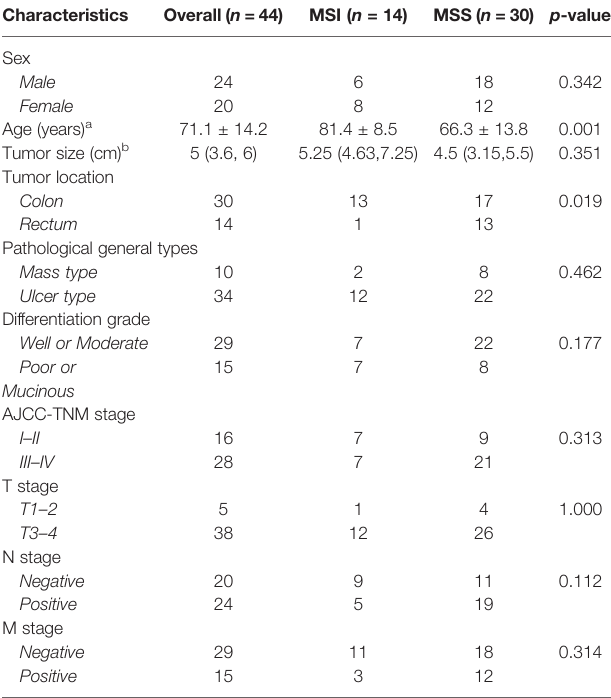
TABLE 1 | Clinicopathological characteristics of included patients. Characteristics